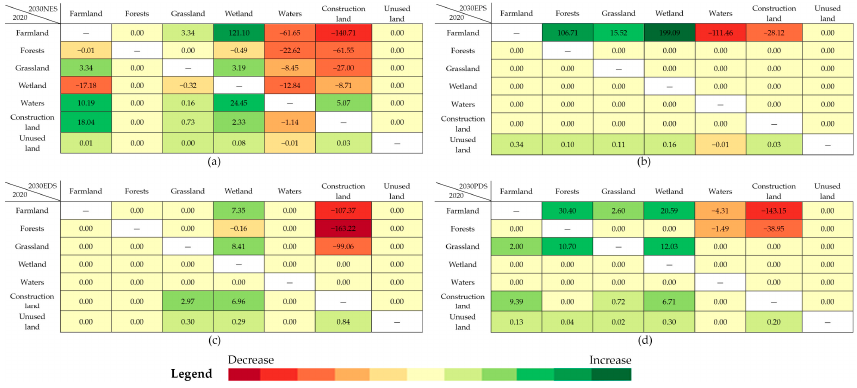
Figure 6. Transfer relationship of CS in DLB from 2020 to 2030 (unit: 10 4 Mg). ( a – d ) In 2020–